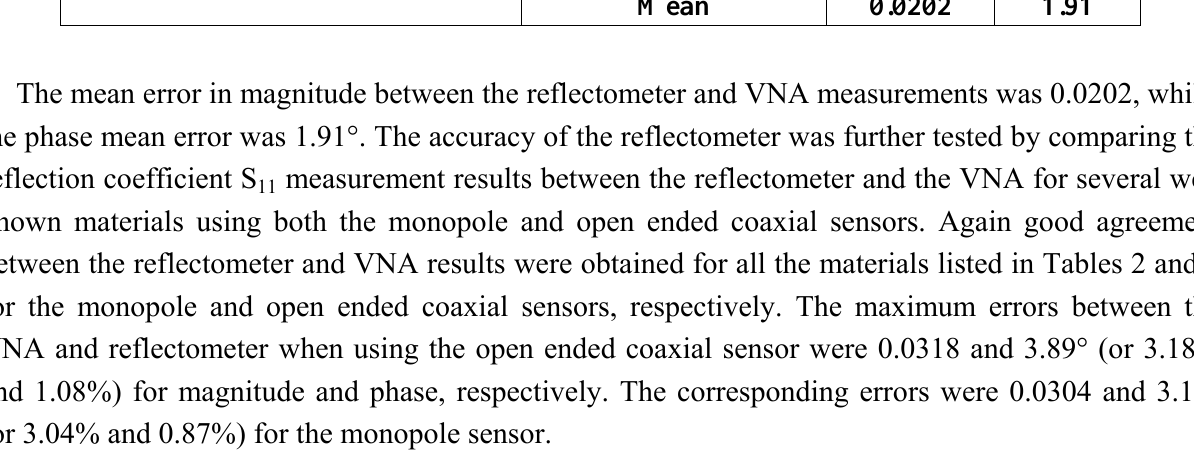
of several known materials using monopole sensor. Table 2. S 11 VNA